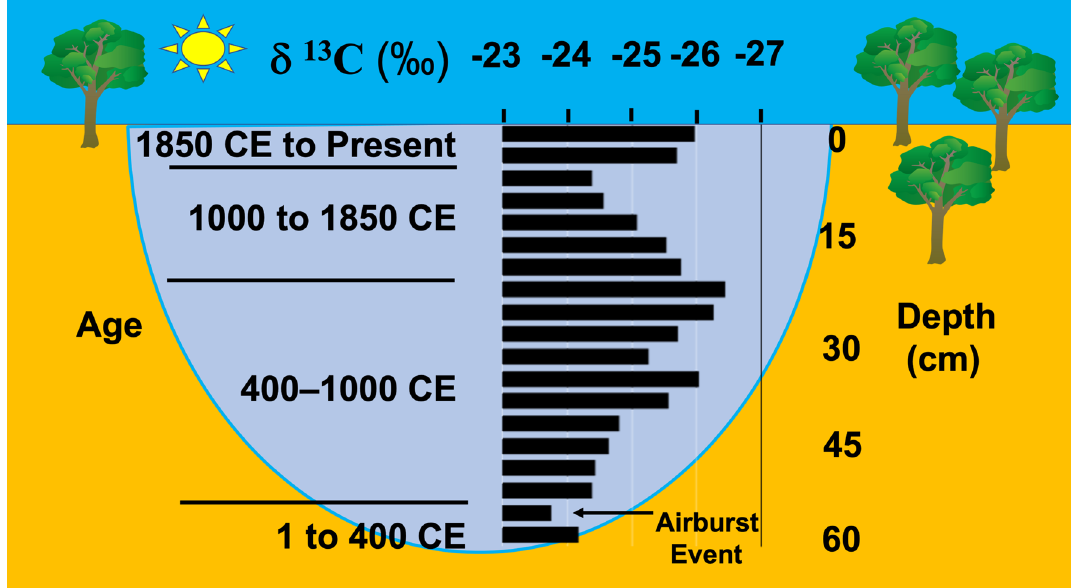
Figure 20. Chronostratigraphy of a Hopewell reservoir at the Miami Fort earthworks and village site showing the delta 13 C values and ages by depth. Kenneth Barnett Tankersley used Microsoft PowerPoint for Mac Version 16.41 (www. micro soft. com) to create this figure.